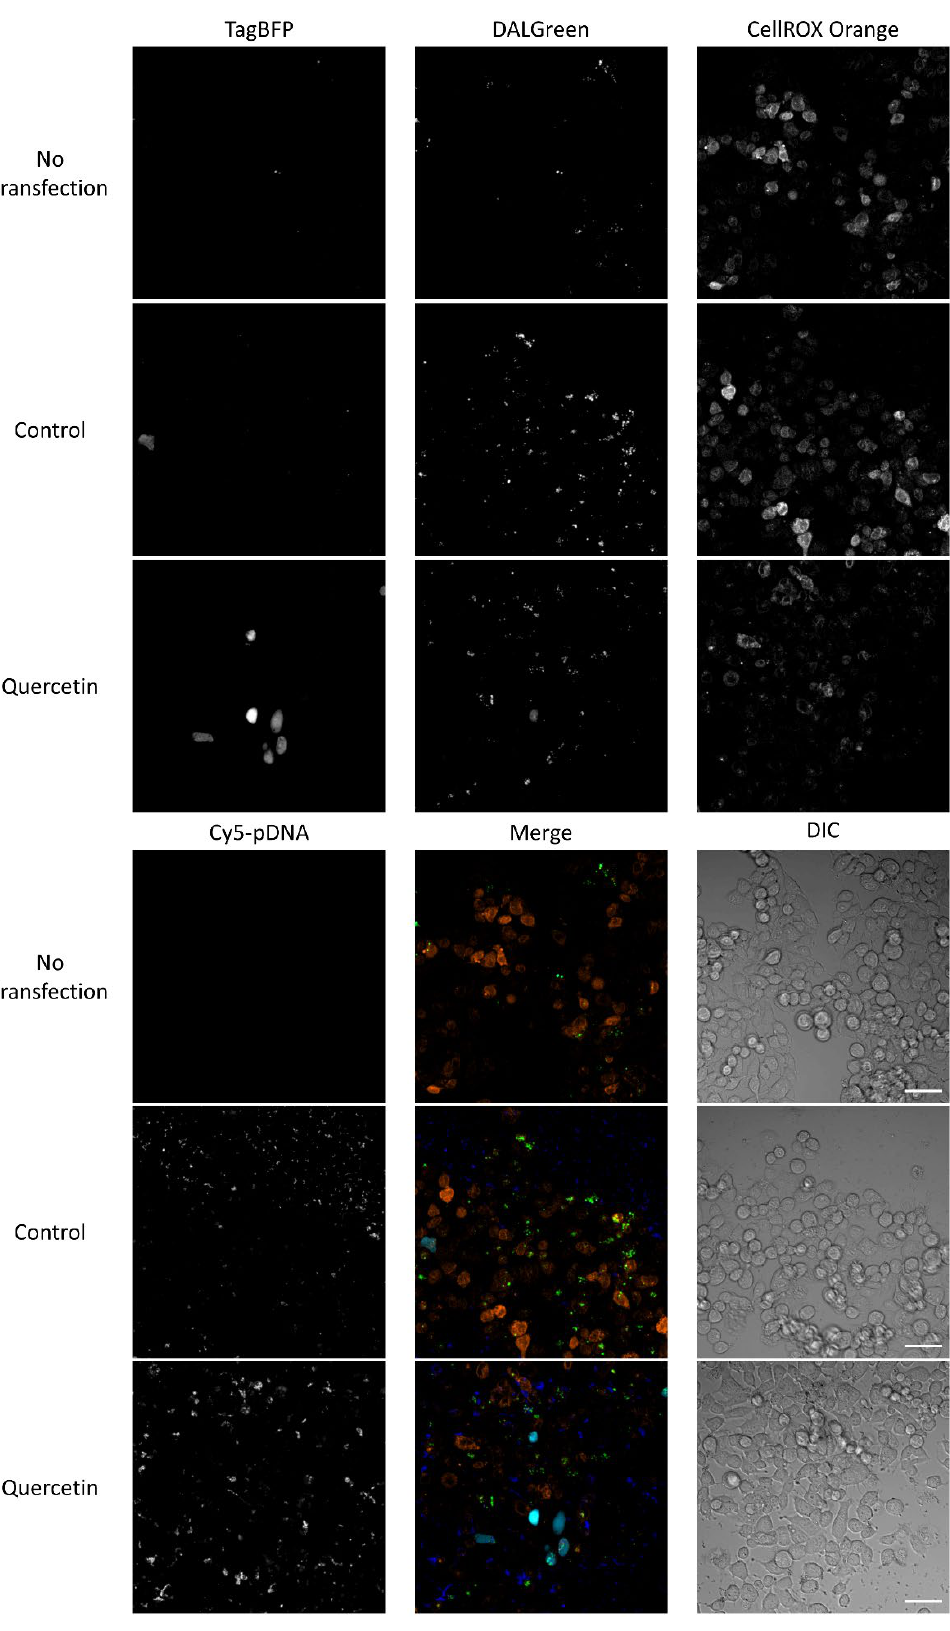
Figure 8. Relationships among transfection efficiency, autophagy, ROS, and cellular uptake in HepG2 cells observed by confocal microscopy. pTagBFP-N/Cy5-labeled pTagBFP-N (0.5 µg each/well) were complexed with Lipofectamine 3000. Concentration of quercetin was 25 µM. Cyan: gene expression (blue fluorescent protein TagBFP). Green: autophagy (DALGreen), Orange: ROS